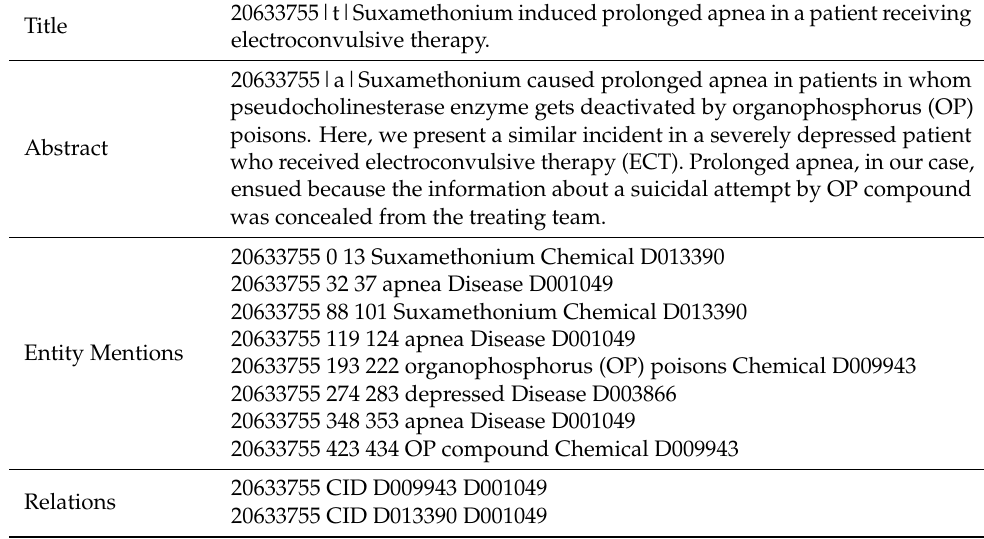
Table 2. A sample with annotation in the CDR